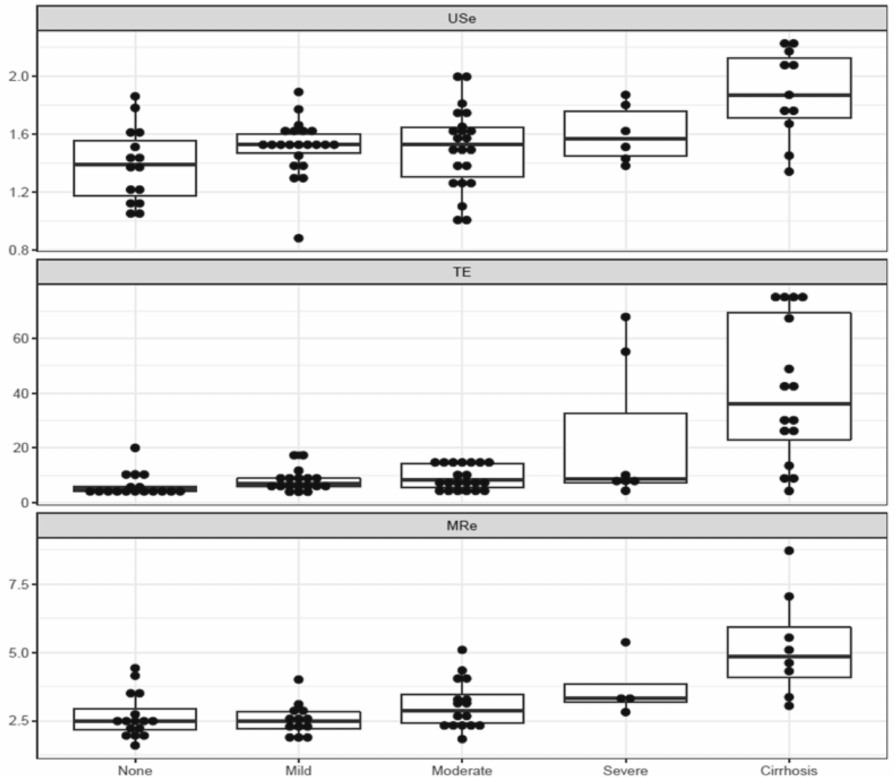
Figure 1. Box- and dotplots of USe, TE and MRe in each fibrosis stage, showing the median (line in box) and interquartile range (IQR, box lines). Upper and lower whiskers represent Q3 + 1.5 × IQR respectively Q1–1.5 × IQR. X-axis: fibrosis stage. Y-axis: Liver stiffness measure (m/s for USe and kPa for TE and